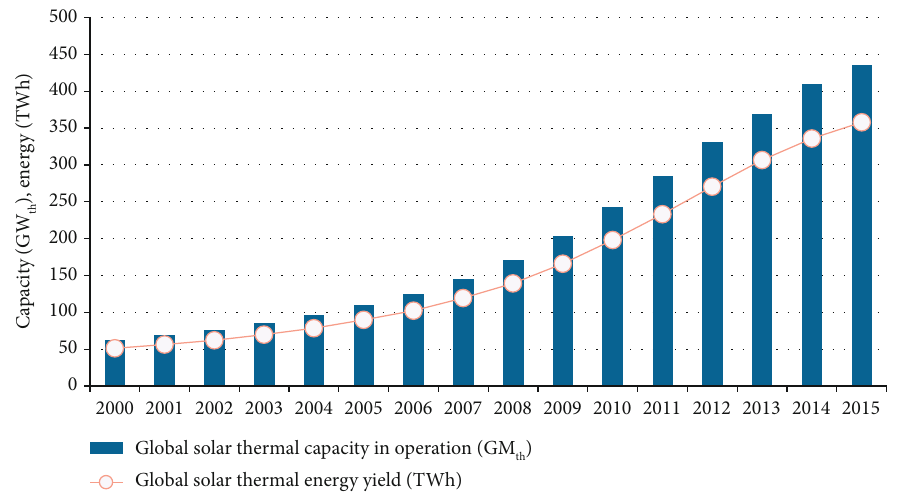
Figure 2: Global solar thermal capacity in operation and annual energy yields 2000-2015